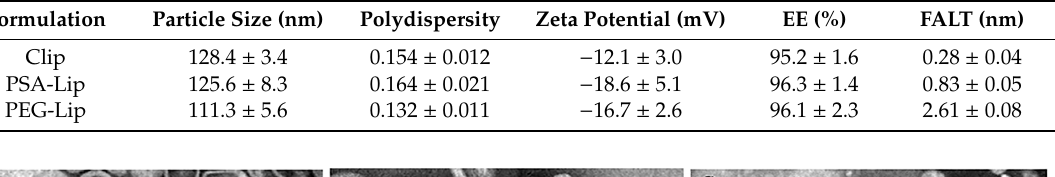
Table 3. The characteristics of the prepared liposomes.